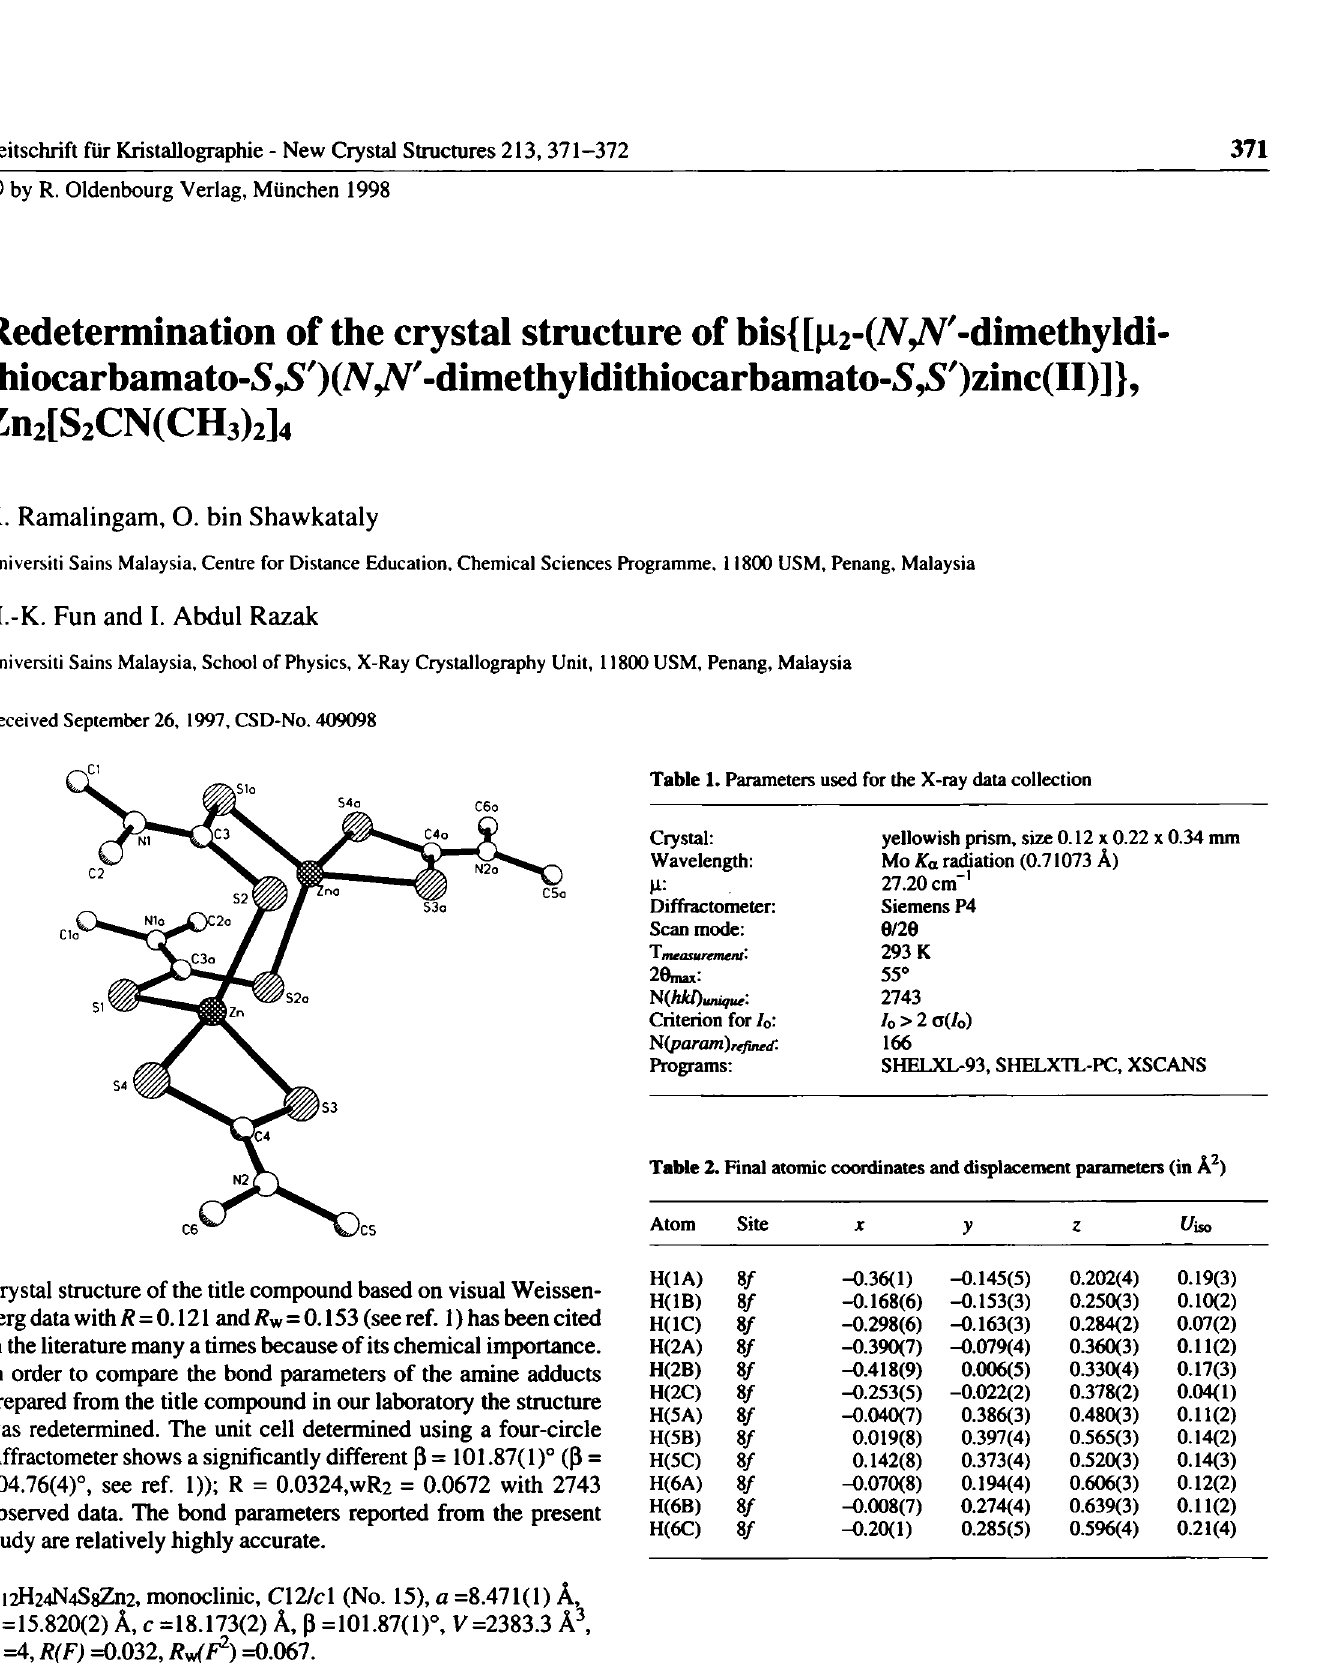
Table 3. Final atomic coordinates and displacement parameters (in A^)